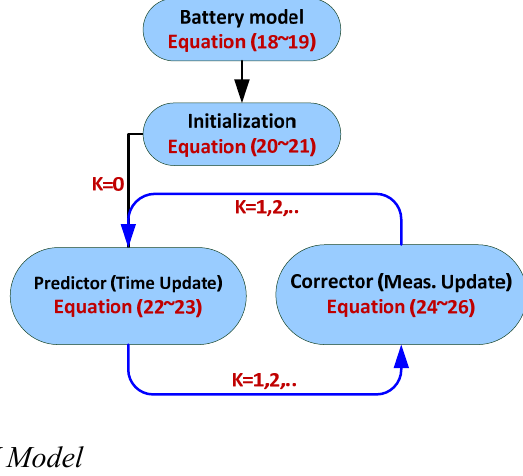
Figure 17. General diagram of the extended Kalman